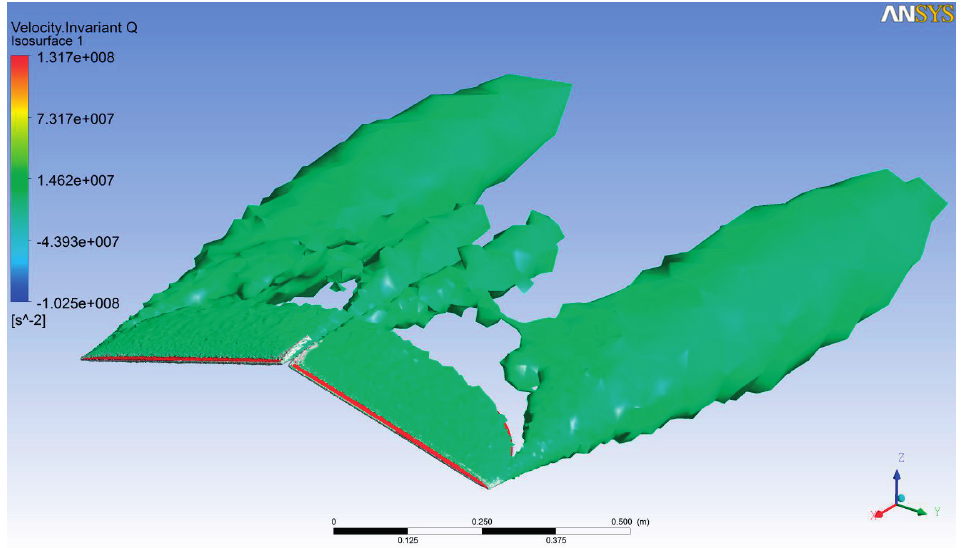
Figure 12. Isosurface of the vorticity on the upper part of the albatross wing, at dihedral angle = − 15°. The leading edge vortex covers the whole wing. The trailing edge vortices on both ends are outstanding.